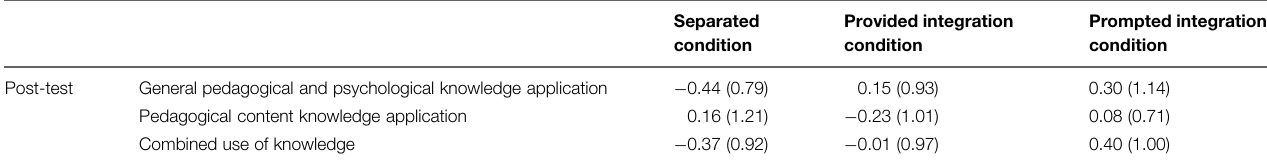
TABLE 3 | Mean (and SD) of z-standardized PPK and PCK application and the simultaneous application of both knowledge types in the three experimental groups.